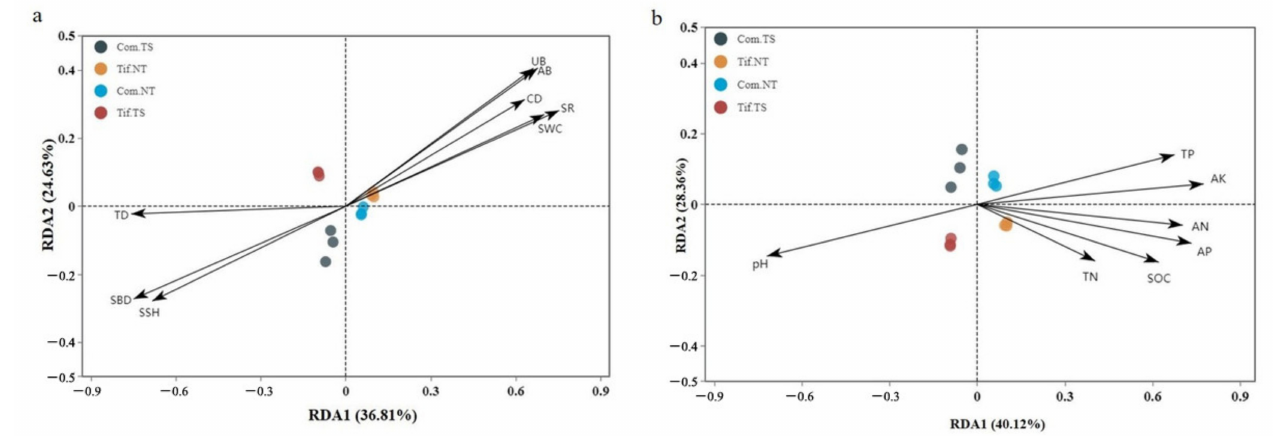
Figure 8. RDA of bacterial communities and environmental factors ( a ) RDA of turf quality indica- tors (TD, CD, AB, UB), soil physical properties (SBD, SSH, SWC, SR) and bacterial communities. ( b ) The RDA of soil chemical properties (TP, AP, TN, AN, AK, SOC, pH) and bacterial communities. Tif.TS, Tifgreen bermudagrass with traffic treatment; Tif.NT, Tifgreen bermudagrass with non-traffic treatment; Com.TS, Common bermudagrass with traffic treatment; Com.NT, Common bermudagrass with non-traffic